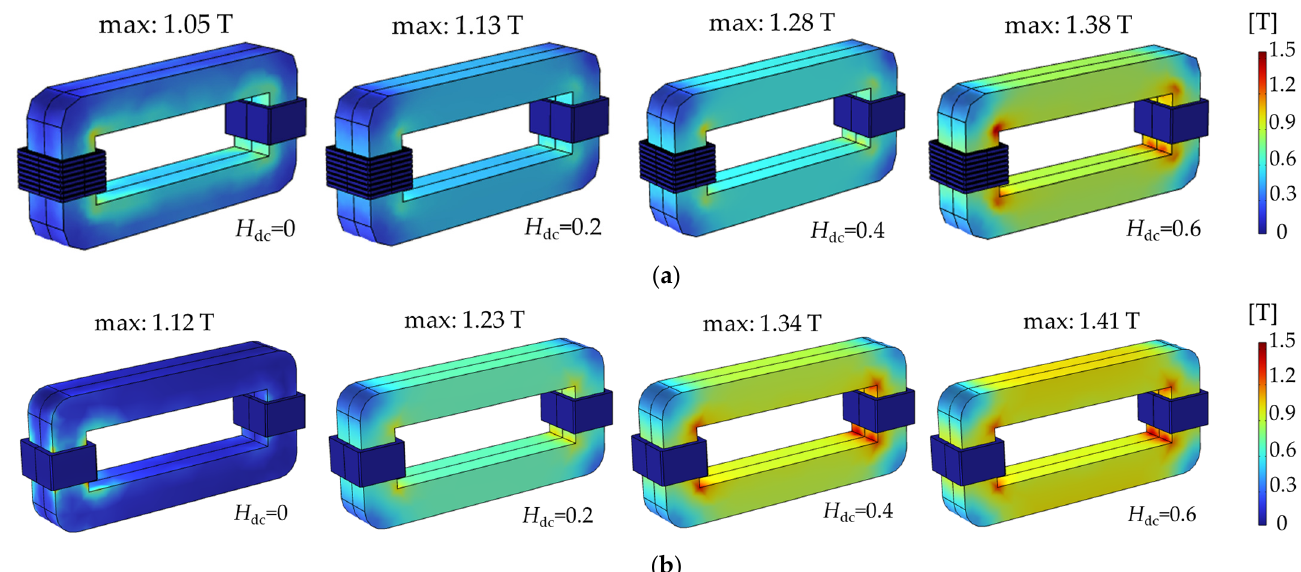
Figure 11. Magnetic flux density distribution. ( a ) Interleaved windings; ( b ) Continuous windings.